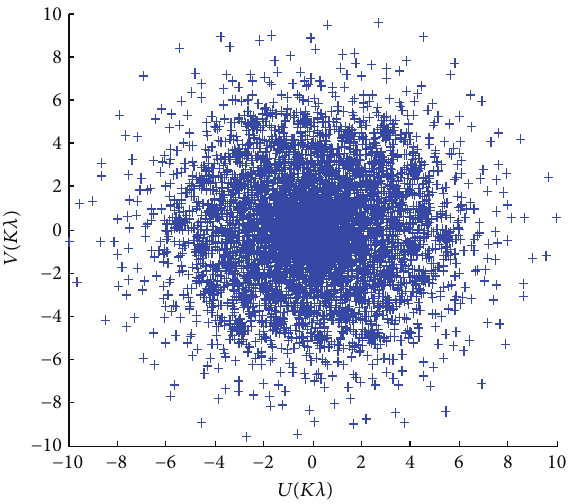
Figure 1: Position of 100 stations of the CSRH used for simulations of instrumental effects. Figure 2: The snapshot 𝑢, V sampling that results from the 3-arm spiral array for a source at zero hour angle and 60 ∘ decline.